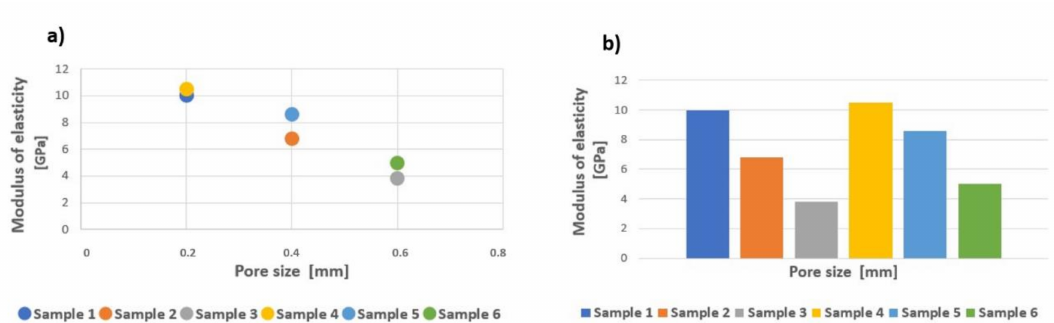
Figure 14. ( a ) Comparison of values of modulus of elasticity considering the pore size. ( b ) The average values of the modulus of elasticity of tested sample types 1–6.